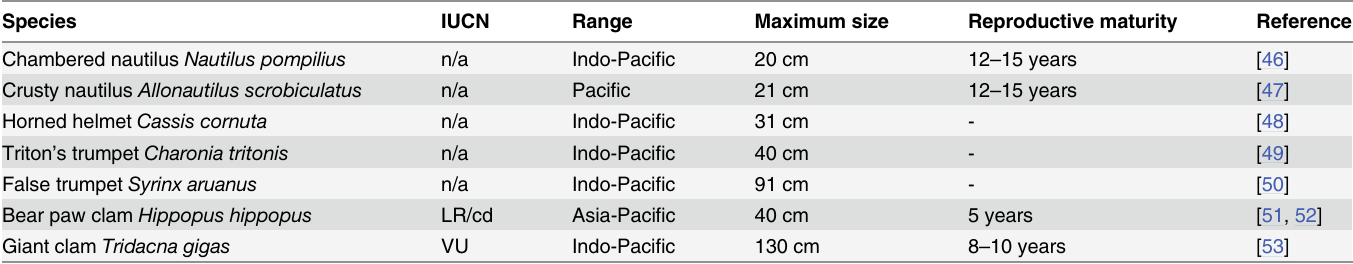
Table 4. Conservation status of marine molluscs. The IUCN Red List status of marine molluscs traded in Java and Bali, Indonesia, with information on their maximum sizes and age of reproductive maturity. Key: n/a = not assessed, LR/cd = Lower Risk, conservation dependent, VU =